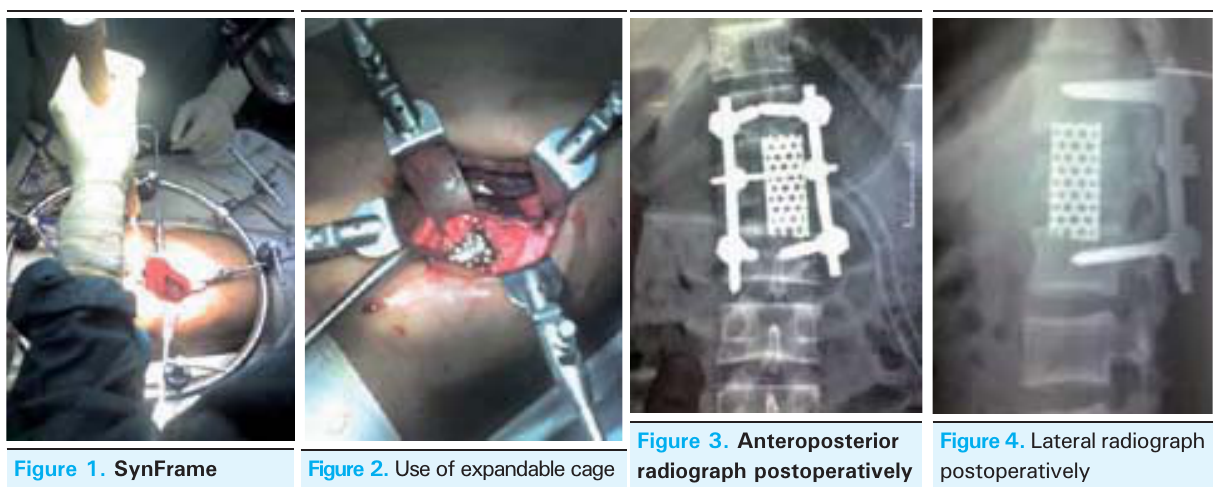
Figure 1. SynFrame Figure 2. Use of expandable cage